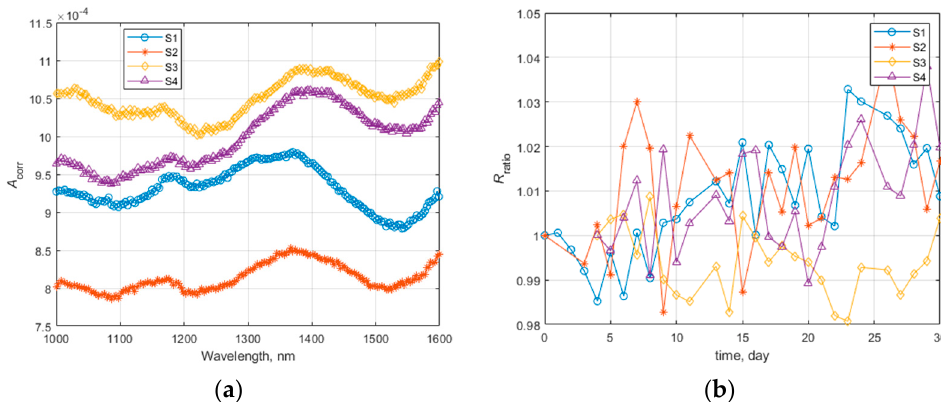
Figure 9. ( a ) Autocorrelation spectra (main diagonal of the 2D-COS synchronous spectrum) of samples with the Ag electrode (S1, S2, S3 and S4); excited from the electrode side; the spectral region for the calculation of the parameter R ratio ( t ) was: R ratio ( t ) = R ( t , 1400 nm)/ R ( t , 1500 nm). ( b ) The R ratio vs. time.